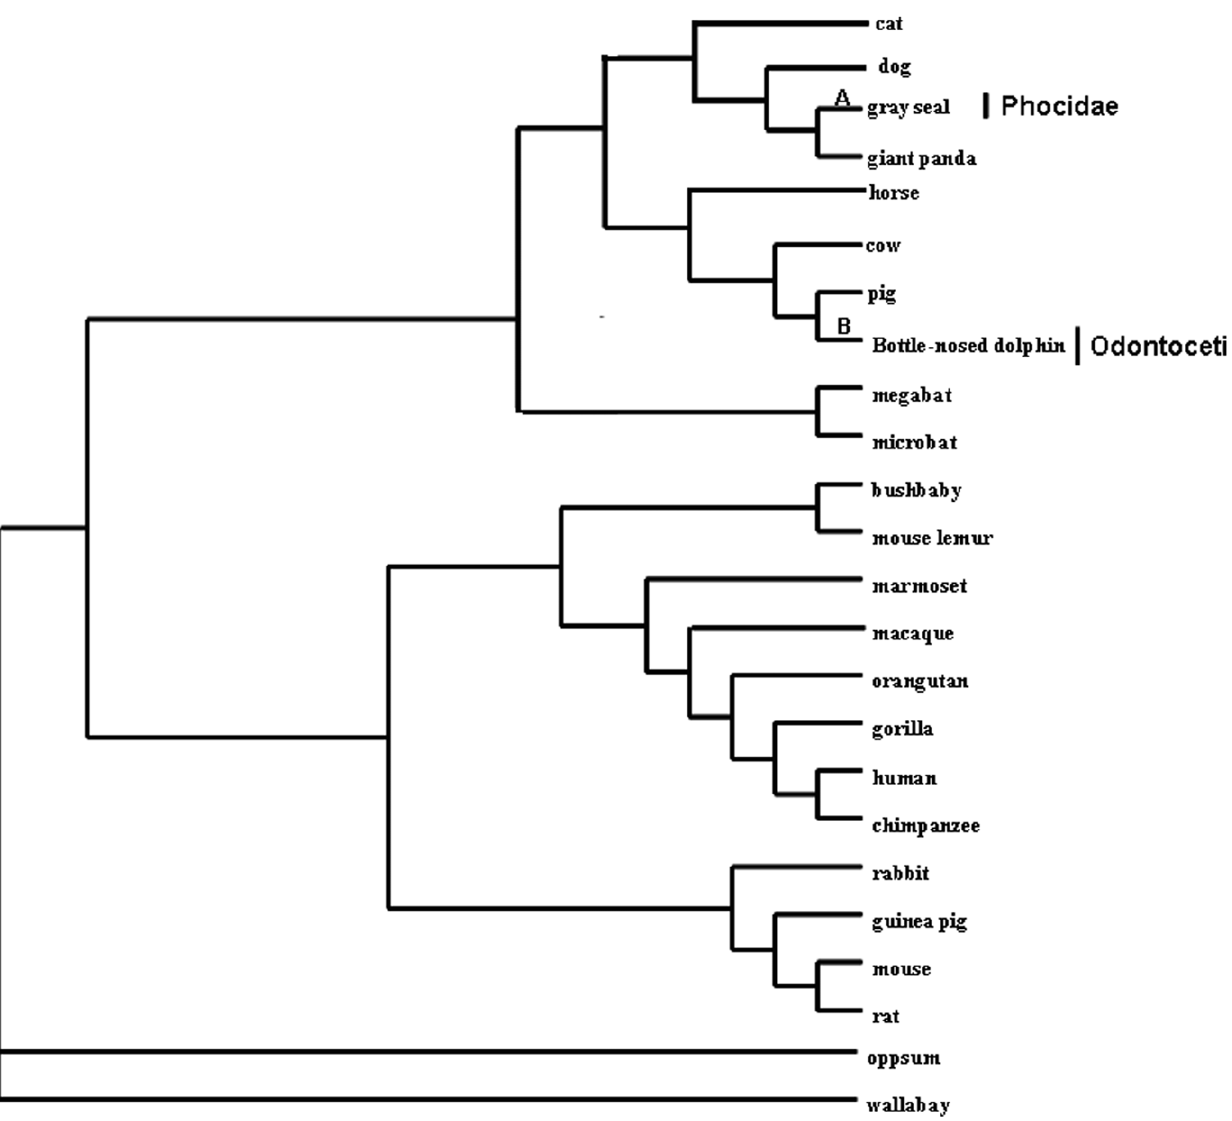
Figure 2. Phylogenetic trees of leptin receptor gene ( LPR ) used for codon-based maximum likelihood analysis in PAML. Tree topology corresponds to those from Murphy et al. (2001a) and Vogel (2005). Use of the alternative trees (Murphy et al. 2001b, 2007; Springer et al. 2004; Beck et al. 2006) gave essentially the same results. Branches A and B in the tree are used in the branch-site models tests.